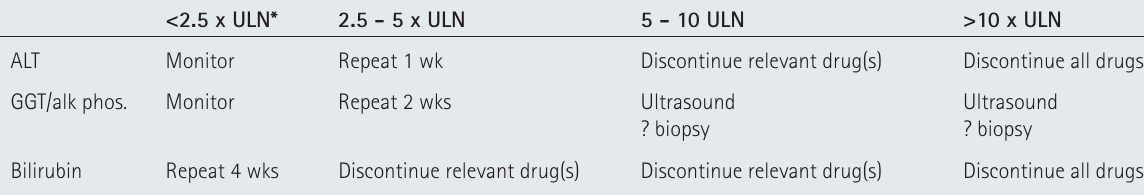
tAble Xiii. GuideliNes foR MANAGiNG